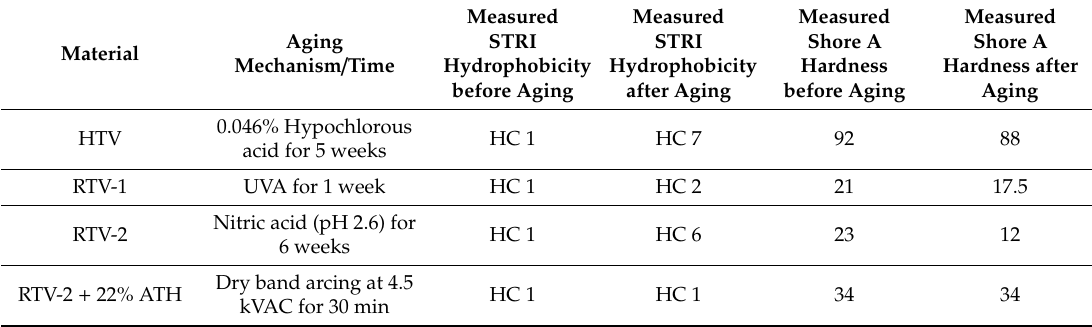
Table 2. List of SIRs and aging mechanisms, as well as measured STRI hydrophobicity and Shore A hardness before and after